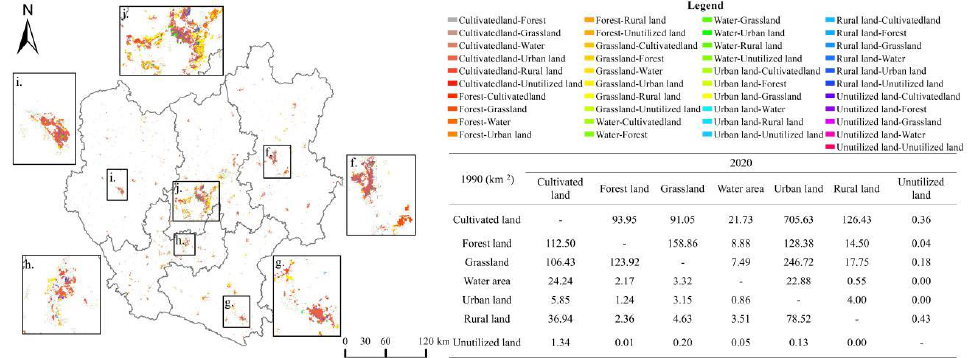
Figure 9. Ecosystem health deterioration areas and their land use transfer matrix for 1990 − 2020.